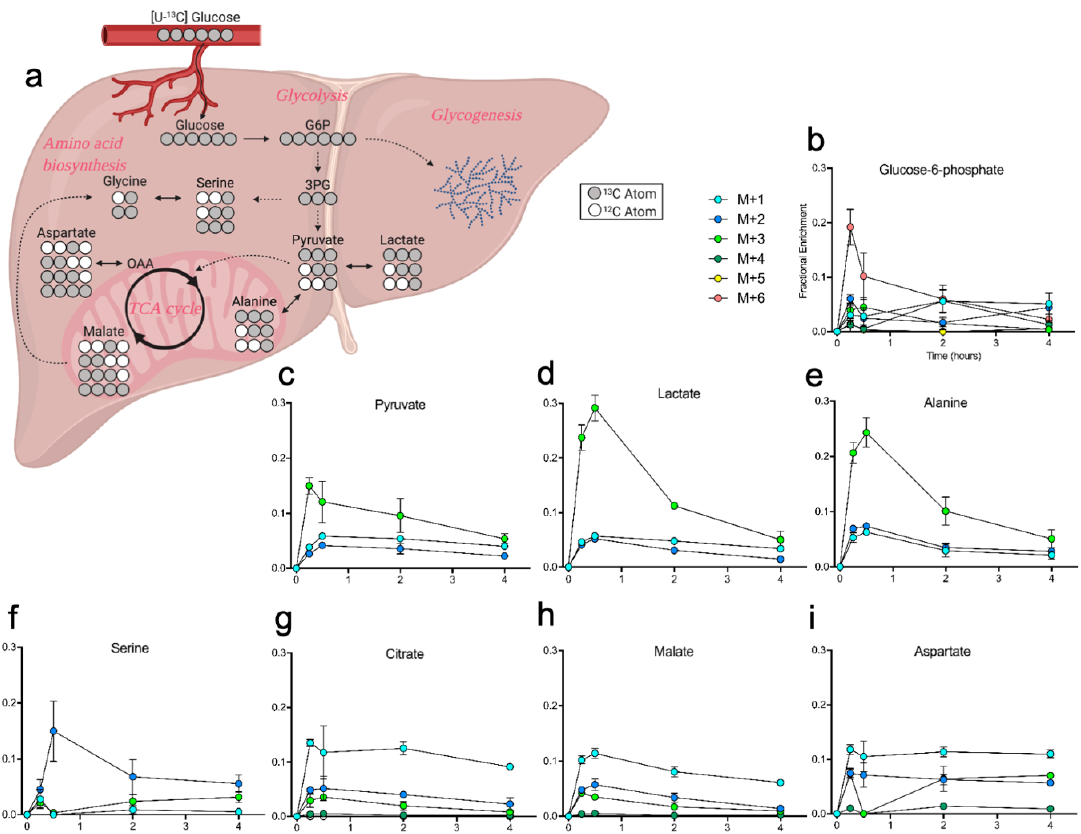
Figure 5. Carbon tracing in the liver after oral gavage of [U- 13 C] glucose. ( a ) Diagram tracing of glucose through central carbon metabolism pathways in the liver. Not all possible labeled isotopologues are shown. Grey circles: 13 C; white circles: 12 C. ( b – i ) Fractional enrichment of 13 C from glucose over time in the labeled isotopologues of glucose-6-phosphate, pyruvate, lactate, Ala, Ser, citrate, malate, and Asp, respectively. Values shown are mean ± SEM ( n = 4–5).